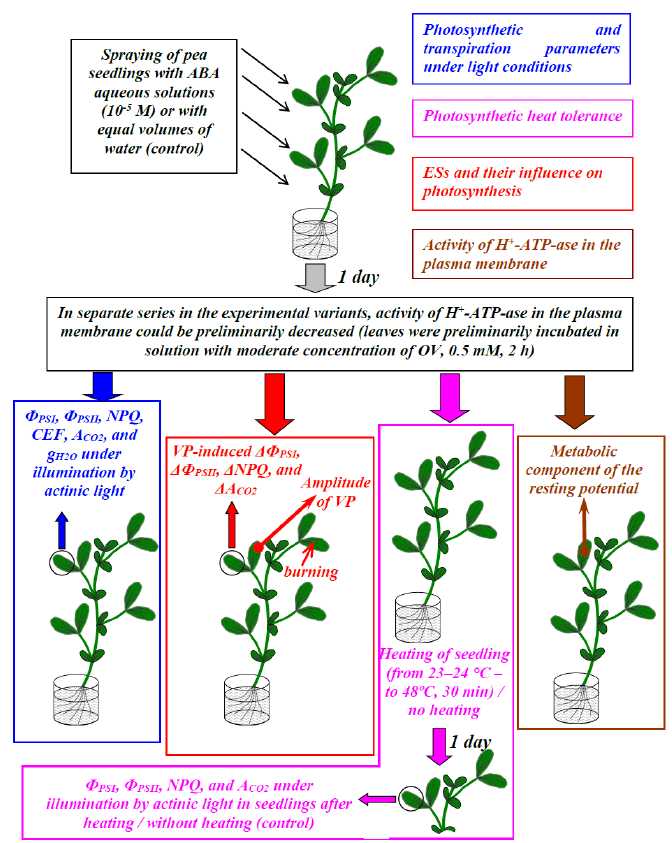
Figure 1. Schemes of different variants of experiments which were used in the current work. Fourteen to 21-day-old pea seedlings were investigated. There were four experimental variants, including an analysis of the exogenous abscisic acid (ABA) influence on (i) photosynthetic parameters under illumination by the blue actinic light (460 nm, 239 µmol m −2 s −1 ); (ii) photosynthetic heat tolerance; (iii) changes in photosynthetic parameters and electrical activity, induced by local burning; (iv) the metabolic component of the resting potential, which was related to the activity of H + -ATP-ase in the plasma membrane. In separate series of the experimental variants, the activity of H + -ATP-ase in the plasma membrane could be preliminarily decreased (leaves were preliminarily incubated in water solution with a moderate concentration of sodium orthovanadate ((OV), 0.5 mM, 2 h); this treatment was used for imitating the influence of exogenous ABA and for the modification of ABA-induced photosynthetic changes. Measurement of the metabolic component of the resting potential was based on fast inactivation of the H + -ATP-ase (minutes) under the action of the high concentration of OV (5 mM); OV was added into solution, which was placed in contact with investigated plant cells, and changes in electrical potential were measured. Local burning of the first mature leaf was induced by a flame (3–4 s, about 1 cm 2 ) [42,43,47,50,53,55]; we did not analyze parameters of propagation of burning-induced electrical signals (variation potential, VP) in detail. Photosynthetic A CO2 was calculated as the difference between the CO 2 assimilation rate before the termination of illumination by the actinic light (after 10 min of illumination) and this rate 5 min after the termination (after 5 min of dark conditions).